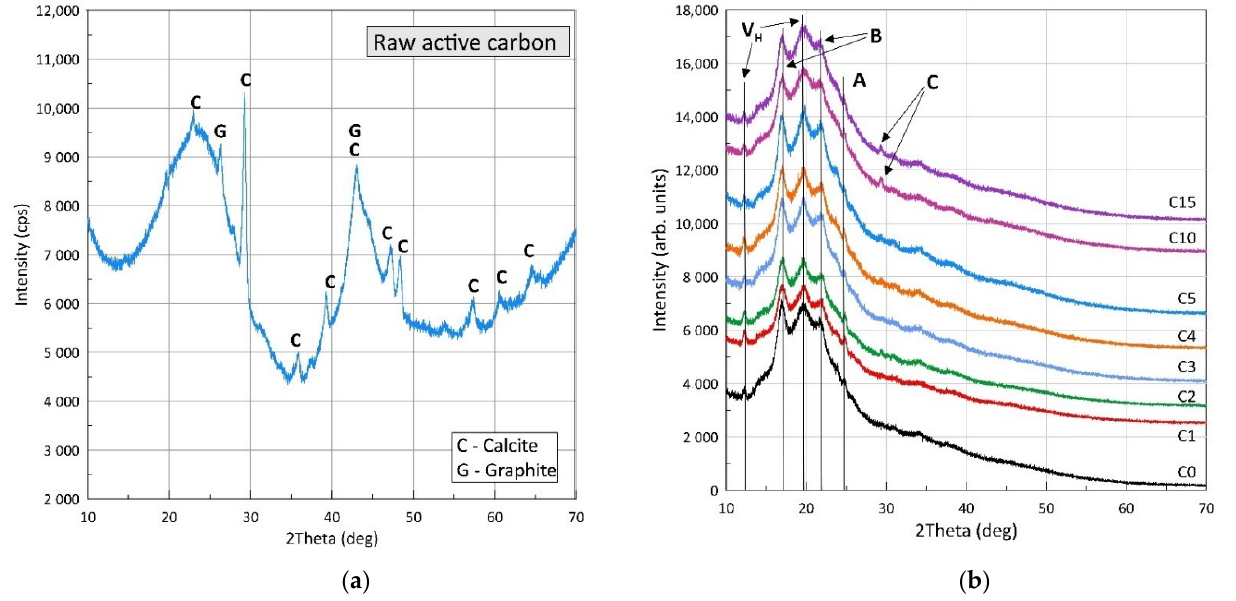
Figure 2. ( a ) XRD pattern of a raw powdered activated carbon; ( b ) XRD pattern of ( a ) thermoplastic starch samples containing 0% (C0), 1% (C1), 2% (C2), 3% (C3), 4% (C4), 5% (C5), 10% (C10), and 15% (C15) powdered activated carbon.